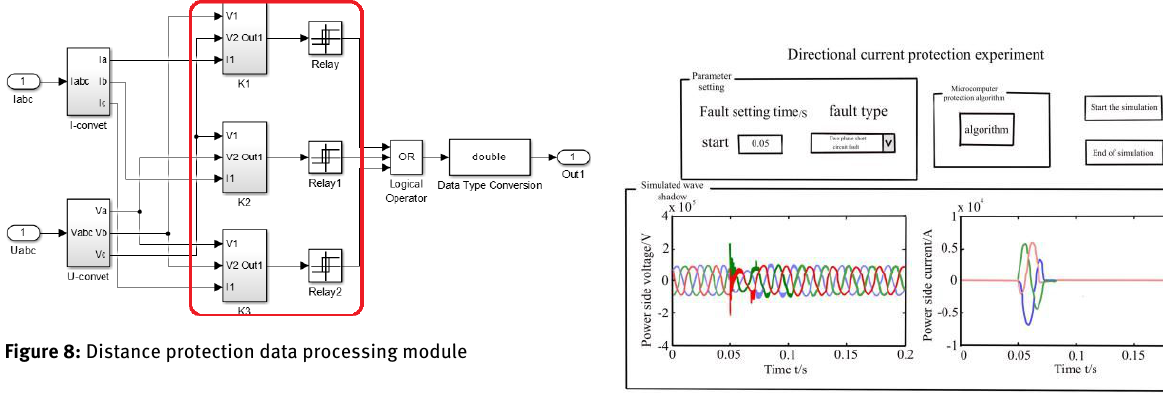
Figure 8 is the data processing module diagram of dis- tance protection. The data processing algorithm not only needs to solve the power angle, but also needs to judge it.